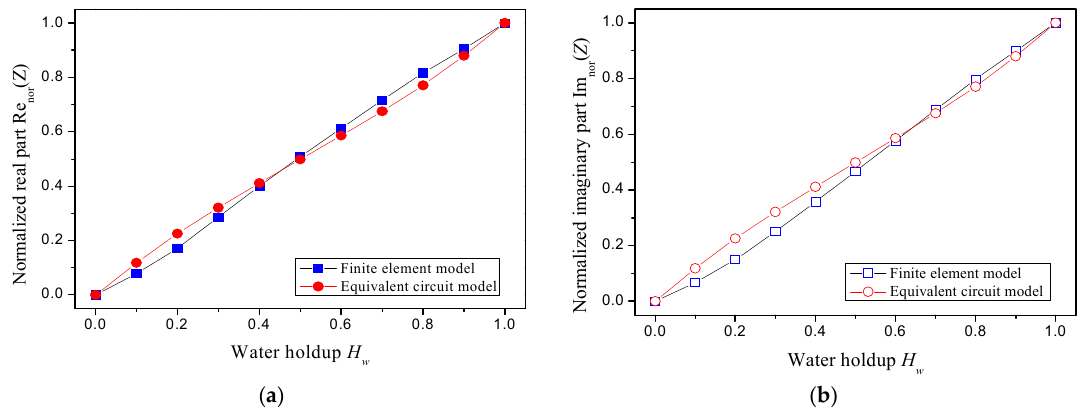
Figure 5. The normalized impedance from the finite element model and equivalent circuit model: ( a ) real part; ( b ) imaginary part.